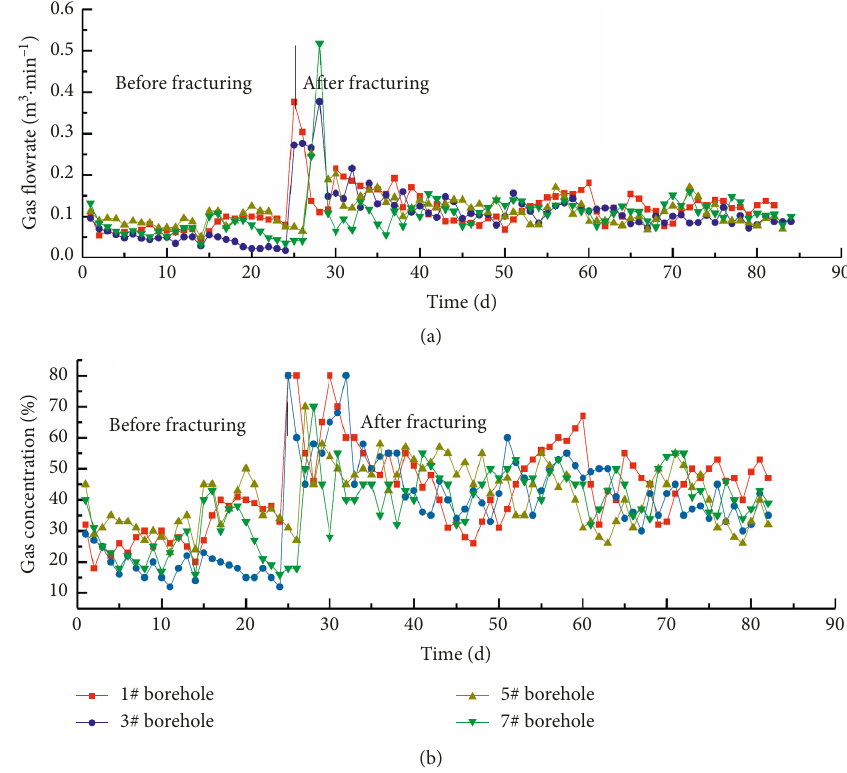
Figure 9: Curves of gas flowrate and gas concentration.